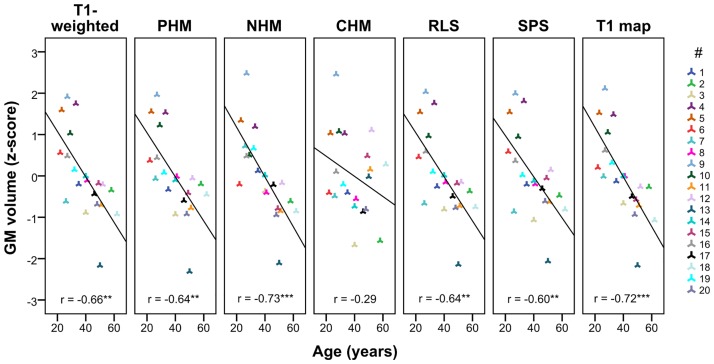
Correlations (r) between subject (#) age and whole-brain GM volumes.CHM (4th column from right) drastically reduced the correlation between age and GM volume originally observed in the native T1-weighted images (1st column). L linear, NL non-linear, PWL piecewise linear, ** p < 0.01, *** p < 0.001.